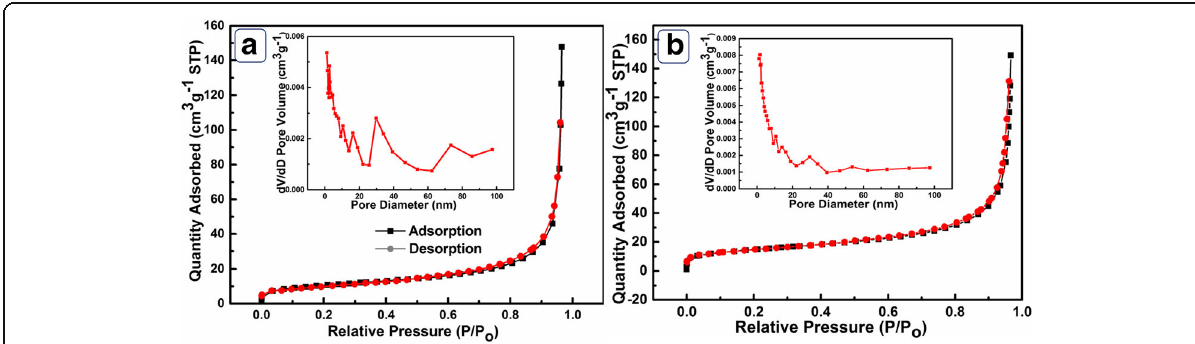
Fig. 3 N 2 adsorption-desorption isotherms of a Ni(OH) 2 HPA and b Ni(OH) 2 BHPA. Insets of a and b are the corresponding pore size distributions,